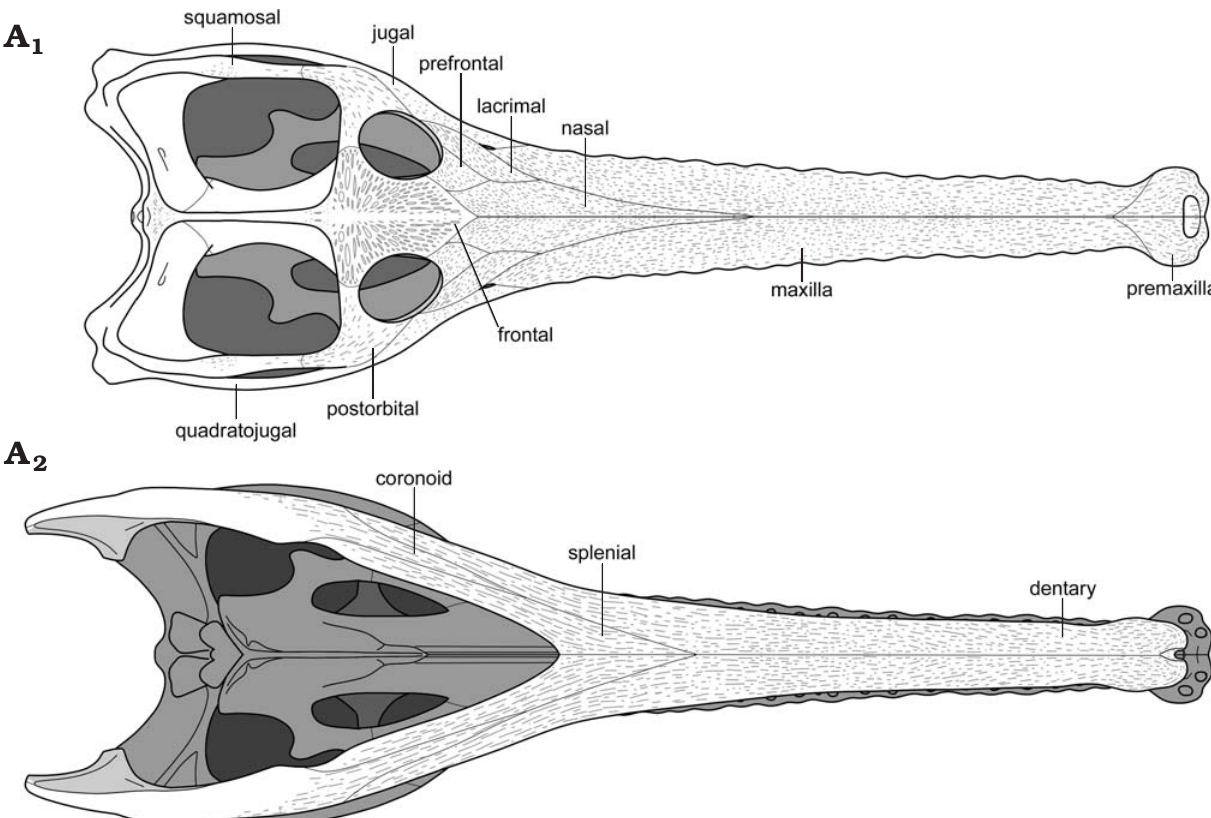
Fig. 4. Reconstruction of teleosauroid thalattosuchian Mystriosaurus laurillardi Kaup, 1834 cranium and mandible in dorsal (A 1 ) and ventral (A 2 ) view. The reconstructed portions are illustrated in SOM: fig. S6. Not to